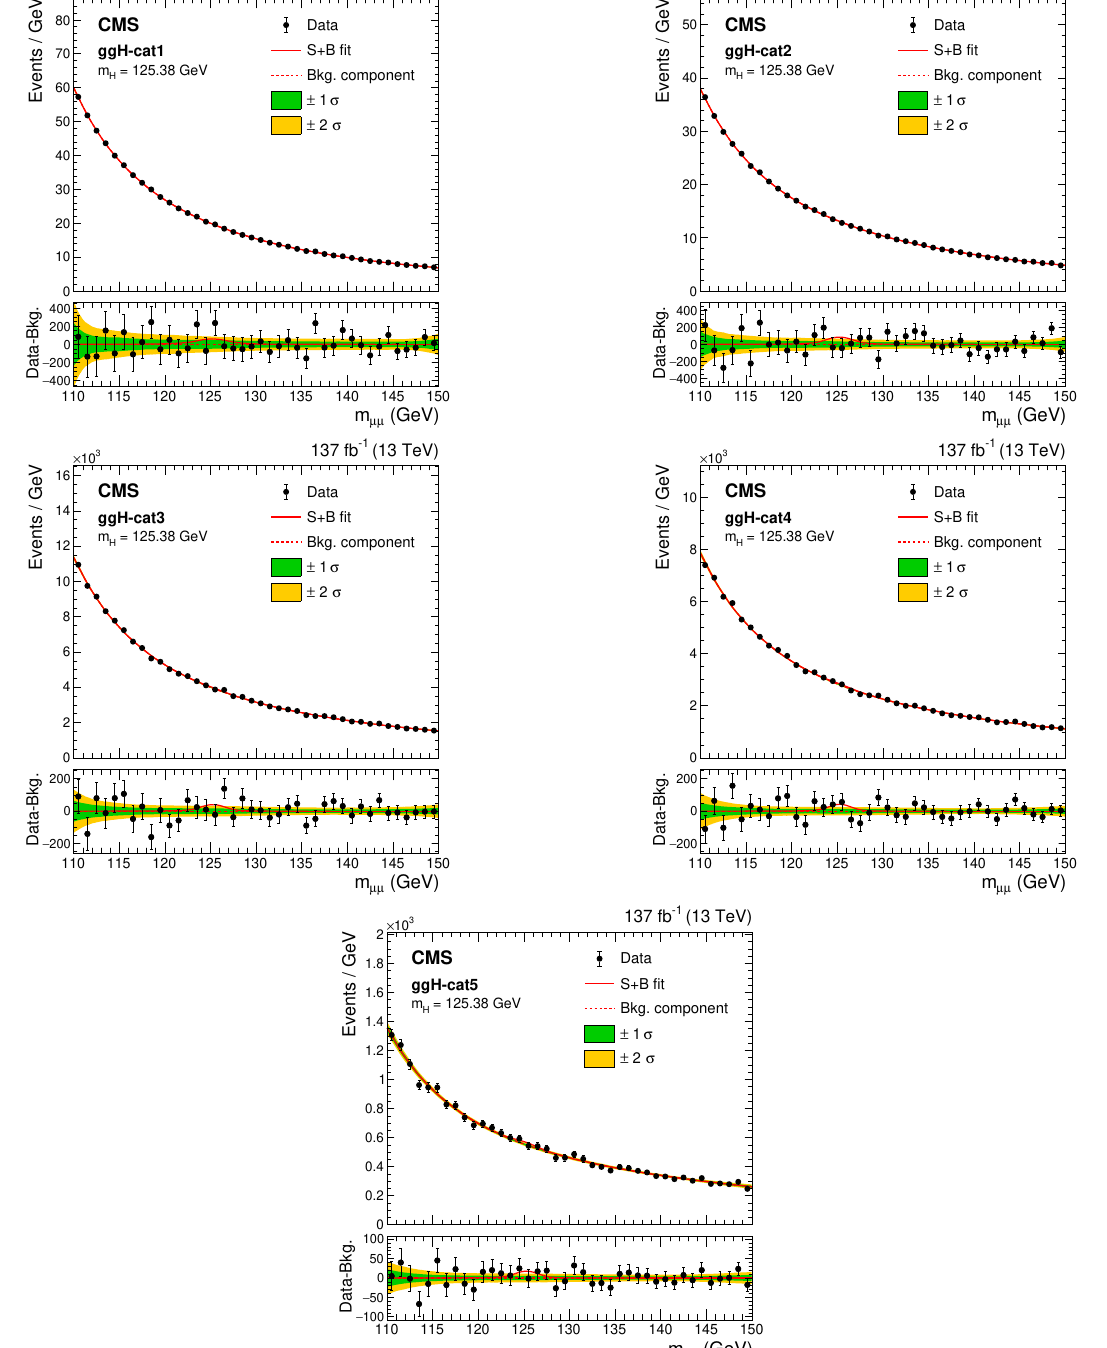
Figure 5 . Comparison between the data and the total background extracted from a S+B fit per- formed across the various ggH subcategories. The one (green) and two (yellow) standard deviation bands include the uncertainties in the background component of the fit. The lower panel shows the residuals after background subtraction and the red line indicates the signal with m extracted from the